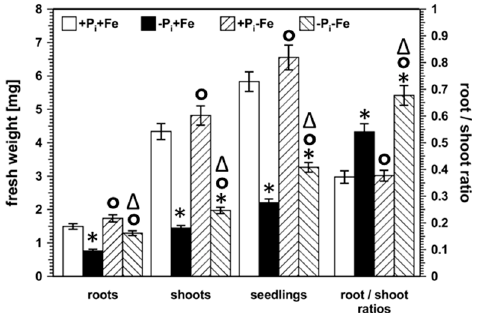
Figure 1. Root, shoot, and seedling fresh weight as well as root to shoot ratios of Col-0. After five days on nutrient sufficient conditions (+P i +Fe), seedlings were transferred to the indicated conditions and allowed to grow for an additional 6 days before harvest. +P i : 500 µ M, − Pi: 5 µ M, +Fe: 50 µ M, − Fe: no Fe added. Error bars indicate SE ( n = 40). Significance analyses between treatments were performed by Student’s t -test (two tailed, equal variances). * p < 0.01 compared to +P i +Fe; ◦ p < 0.01 compared to − P i +Fe; ∆ p < 0.01 compared to +P i − Fe. The respective numbers are shown in Datasets S1 and